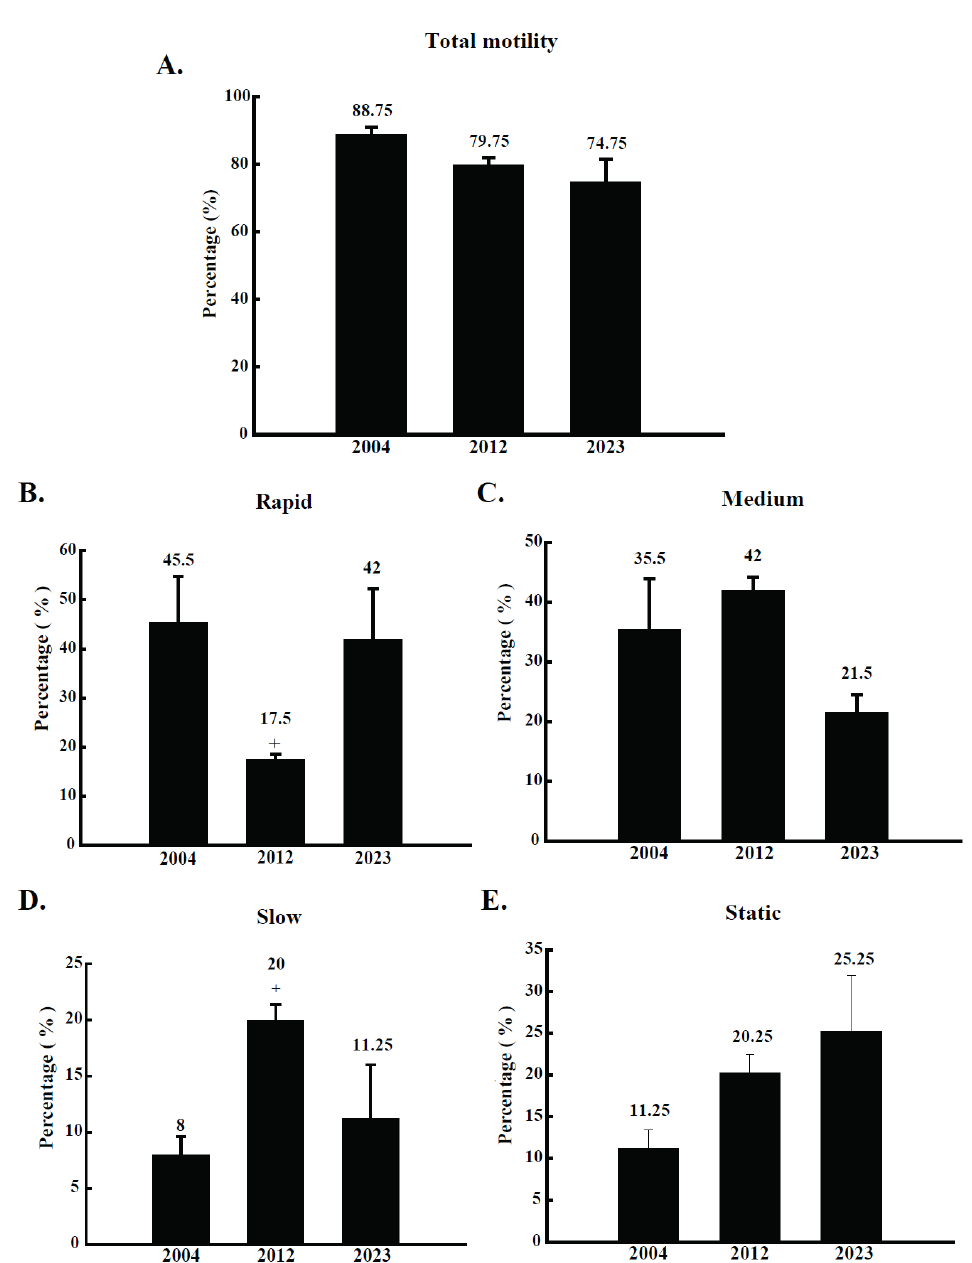
Figure 1. Percentage of motile boar sperm from boar number 2004, 2012, and 2023. (A) total motility, (B) rapidly moving sperm, (C) moderately moving sperm, (D) slow moving sperm, and (E) static sperm. Semen was collected at five different time from the boars (n = 5). The collected semen was divided in triplicates and applied to CASA analysis. The results are expressed as mean±SD. p<0.05. CASA, computer assisted semen analysis; SD, standard